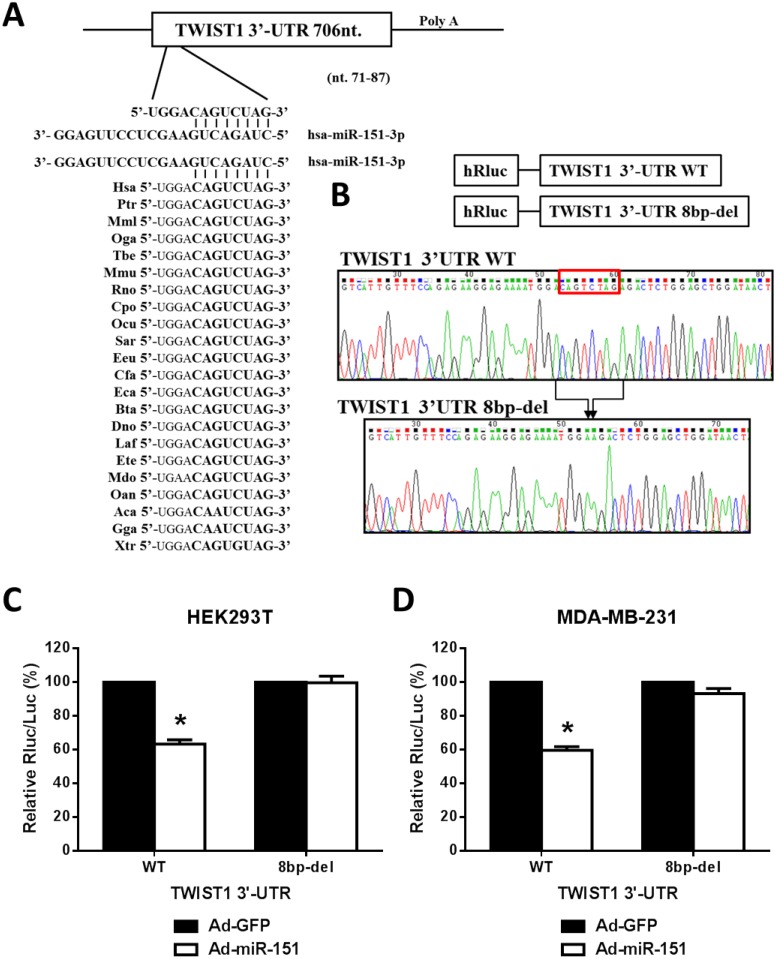
The TWIST1 3’UTR contains a putative miR-151-3p binding site that is required for miR-151-3p regulation of TWIST1 expression.(A) There is a putative miR-151 binding site in the human TWIST1 3’UTR (nucleotide position 71 to 87) as predicted by DIANAmT, miRanda, miRDB, miRWalk, PICTAR5 and Targetscan. The sequences containing the miR-151 binding site of the TWIST1 3’-UTRs of different species are aligned, including Has/ Human/ Homo sapiens (Symbol/ Common name/ Species); Ptr/ Chimpanzee/ Pan troglodytes; Mml/ Rhesus/ Macaca mulatta; Oga/ Bushbaby/ Otolemur garnetti; Tbe/ Treeshrew/ Tupaia belangeri; Mmu/ Mouse/ Mus musculus; Rno/ Rat/ Rattus norvegicus; Cpo/ Guinea pig/ Cavia porcellus; Ocu/ Rabbit/ Oryctolagus cuniculus; Sar/ Shrew/ Sorex araneus; Eeu/ Hedgehog/ Erinaceus europaeus; Cfa/ Dog/ Canis familiaris; Fca/ Cat/ Felis catus; Eca/ Horse/ Equus caballus; Bta/ Cow/ Bos taurus; Dno/ Armadillo/ Dasypus novemcinctus; Laf/ Elephant/ Loxodonta africana; Ete/ Tenrec/ Echinops telfairi; Mdo/ Opossum/ Monodelphis domestica; Oan/ Platypus/ Ornithorhynchus anatinus; Aca/ Lizard/ Anolis carolinensis; Gga/ Chicken/ Gallus gallus; and Xtr/ Frog/ Xenopus tropicalis. (B) The wild type (WT) TWIST1 3’UTR reporter plasmid (TWIST1-3’UTR-WT) and the deleted mutant TWIST1 3’UTR reporter plasmid (TWIST1-3’UTR-8bp-deletion) that lacked the miR-151-3p target sequence 5’-CAGTCTAG-3’were constructed and confirmed by DNA sequencing. (C) After infection with adenoviruses expressing miR-151 (Ad-miR-151) or GFP (Ad-GFP) for 24 hours, HEK293T or MDA-MB-231 cells (4 × 105) were transfected with psiCHECKTM-TWIST1-3’-UTR-WT or psiCHECKTM-TWIST1-3’-UTR-8bp-deletion for luciferase reporter assay. All experiments were performed in triplicate. Each bar represents the mean ± SEM (standard error of the mean). *, P < 0.05.